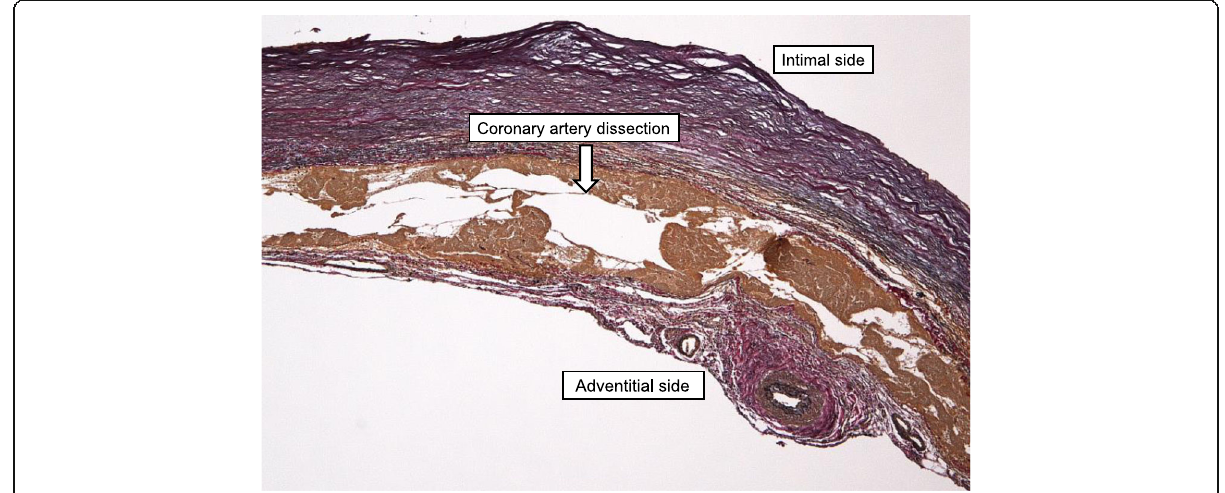
Fig. 5 Histopathological findings of the excised coronary artery aneurysm. Coronary artery dissection (arrow) is evident. Elastica van Gieson-stained